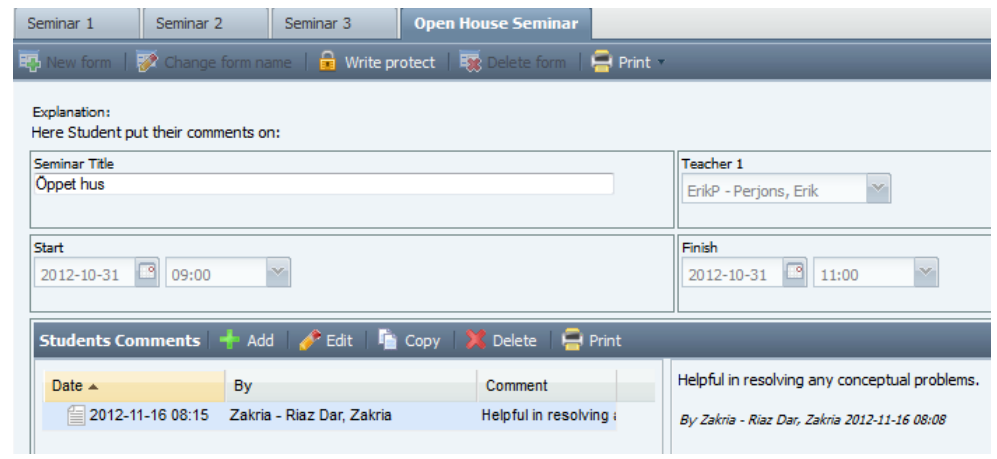
Figure A9. Step form for Student comments on